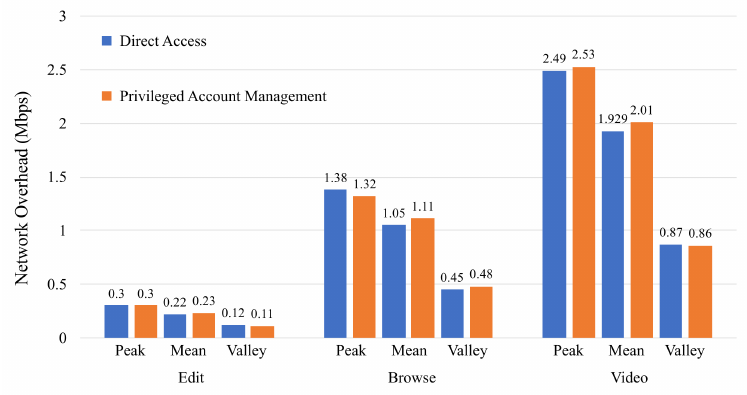
Figure 10. The accuracy of the original model and the improved model.